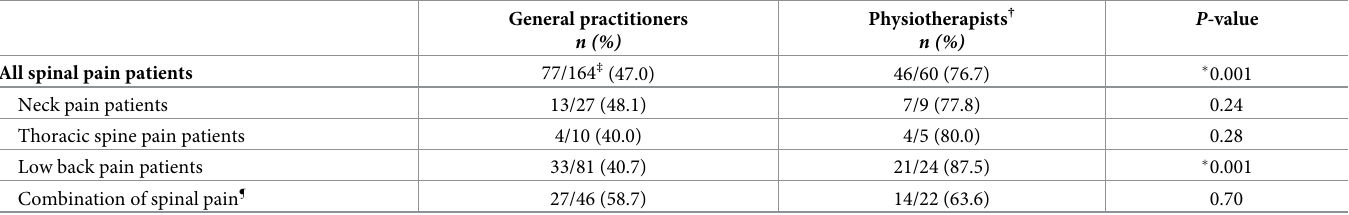
Table 7. Proportion of general practitioners (n = 164) and physiotherapists (n = 60) prescribing at least one physiotherapy intervention for spinal patients based on recommendations from clinical practice guidelines for the management of spinal pain